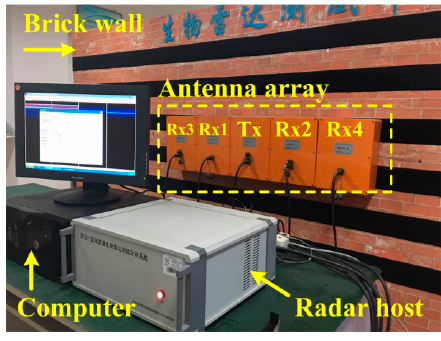
Figure 3. Schematic diagram of the Kalman